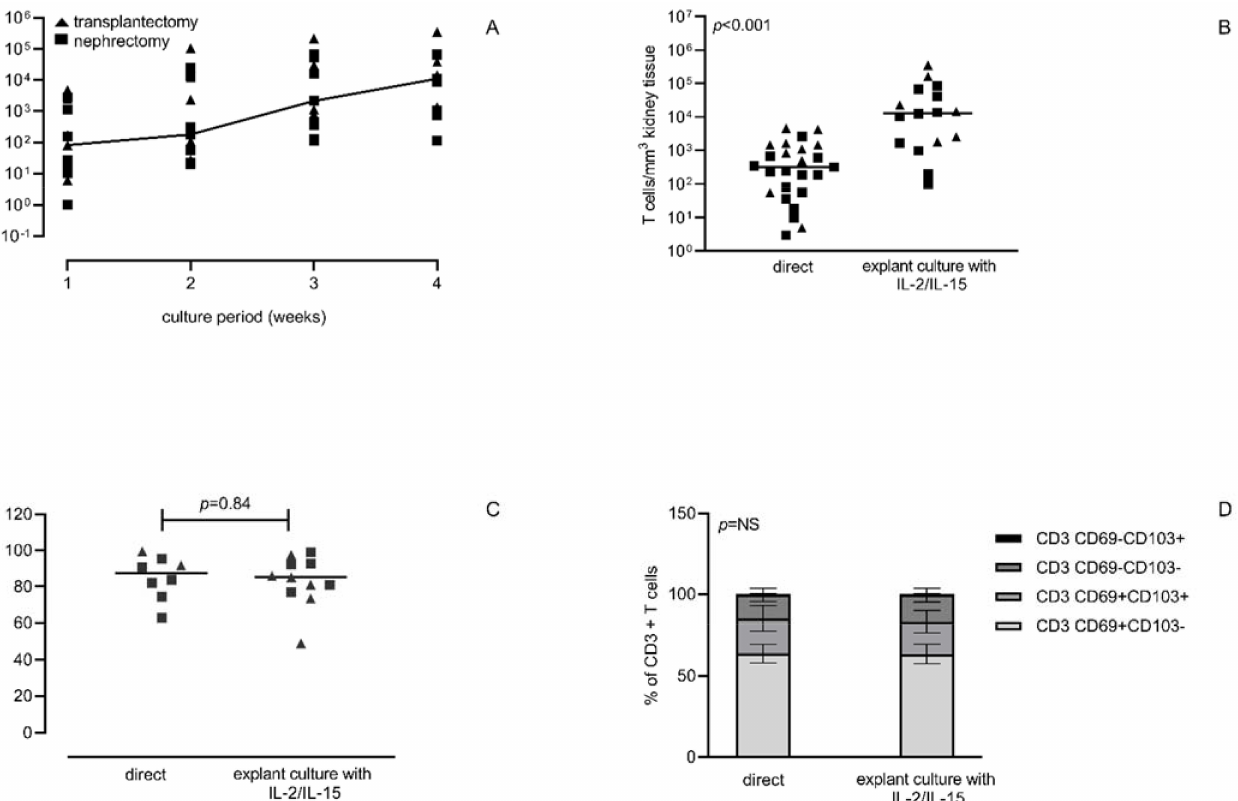
Figure 1. Increased T cell numbers following explant culture of different sources of kidney tissue with exogenous IL-2 and IL-15. T cell numbers ( y -axis) were determined on a weekly basis during four weeks of explant culture in the presence of exogenous IL-2 and IL-15 for the different sources of kidney tissue ( n = 10 nephrectomies and n = 6 transplantectomies), using flow cytometry thereby normalizing for the different volumes of kidney tissue obtained ( A ). data depicted representing the median of the different samples per week. In ( B ), the final number of T cells is depicted on the y -axis, again normalizing for the amount of kidney tissue obtained. In ( C ), the percentage of CD69+CD103+/ − T cells is depicted. The horizontal line represents the median of the different samples. The squares represent data obtained for nephrectomies and the triangles’ display data obtained for transplantectomies. In ( D ), the distribution of CD69 and CD103 for CD3+ T cells is depicted (average ±